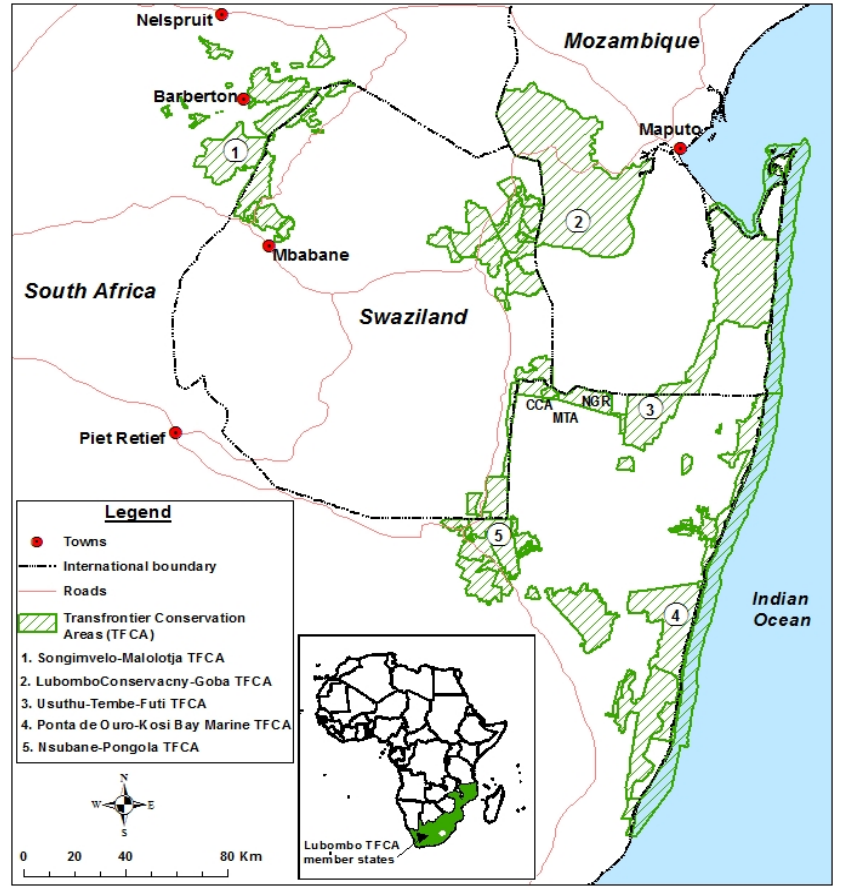
Figure 2. Location of Usuthu–Tembe–Futi TFCA within the Lubombo TFCA. MTA = Mathenjwa Tribal Authority; CCA = Usuthu Gorge Community Conservation Area; NGR = Ndumo Game Re- Authority; CCA = Usuthu Gorge Community Conservation Area; NGR = Ndumo Game serve.